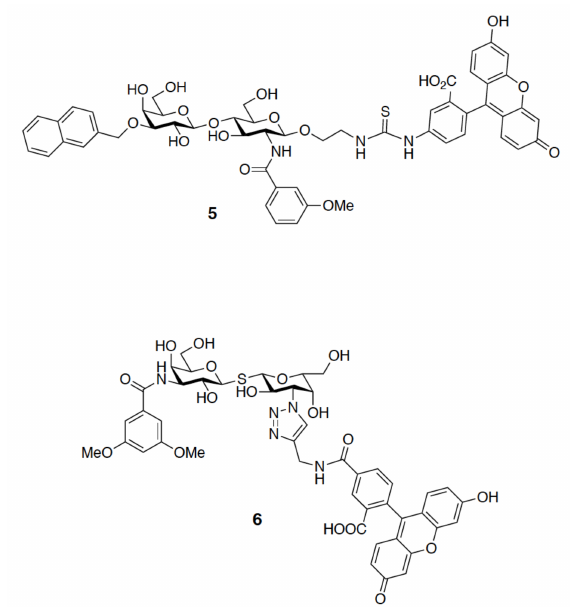
Figure 13. Molecular structures of 2-(fluorescein-5-ylthioureidoethyl) [3- O -(naphthalen-2-methyl)- β - D -galactopyranosyl]-(1 → 4)-2-(3-methoxybenzamido)-2-deoxy- β - D -glucopyranoside, 5 and 3,3 (cid:48) -dideoxy-3-[4-(fluorescein-5-yl-carbonylaminomethyl)-1H-1,2,3-triazol-1-yl]-3 (cid:48) -(3,5-di- methoxybenzamido)-1,1 (cid:48) -sulfanediyl-di- β - D -galactopyranoside, 6